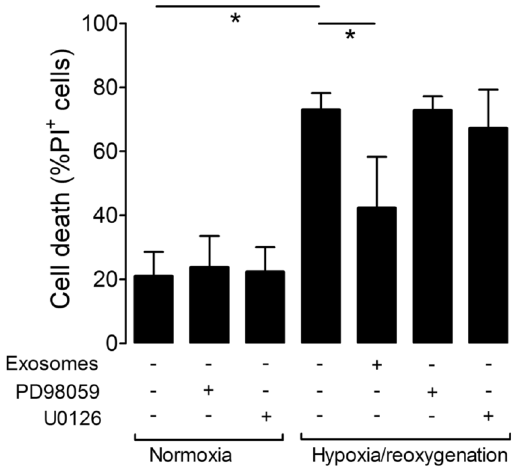
Figure 3. HUVEC exosomes protect cardiomyocytes via the ERK1/2 signalling pathway. The ERK1/2 inhibitors U0126 and PD98059 prevented protection of cardiomyocytes by HUVEC exosomes (N = 3; * P < 0.05).